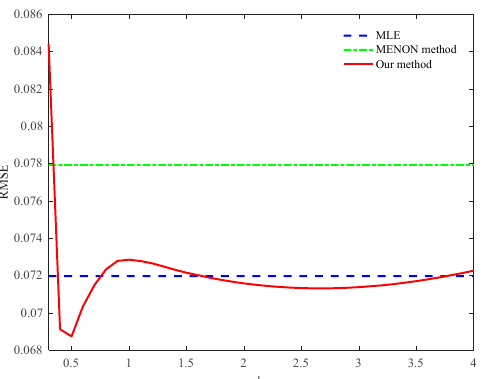
Figure 9. The relationship between k and RMSE in the data of simulated Weibull distribution. Through our analysis, when k = 0.4 ∼ 0.7 and k = 1.7 ∼ 3.7, the RMSE of the proposed